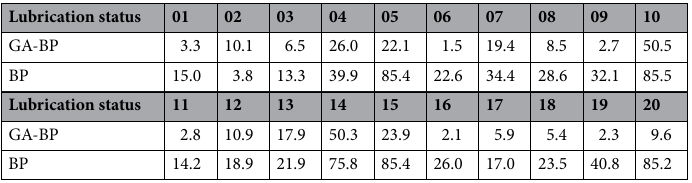
Table 6. Prediction error of equipment lubrication